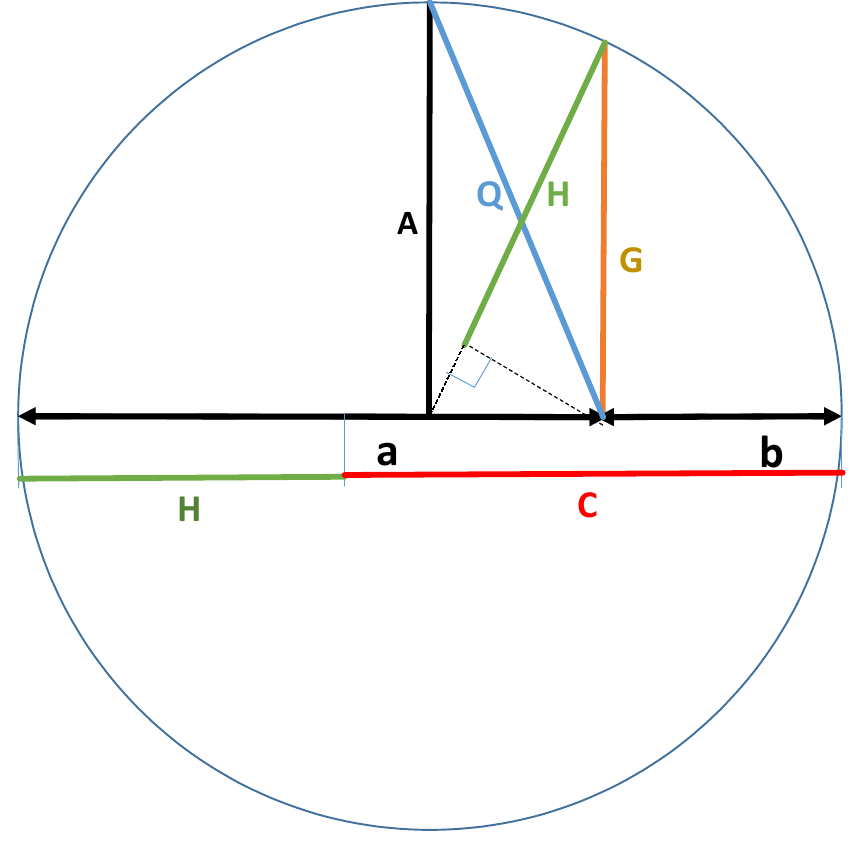
Figure 1. Classic Greek construction of Pythagorean Figure 1: Classic Greek construction of Pythagorean means.